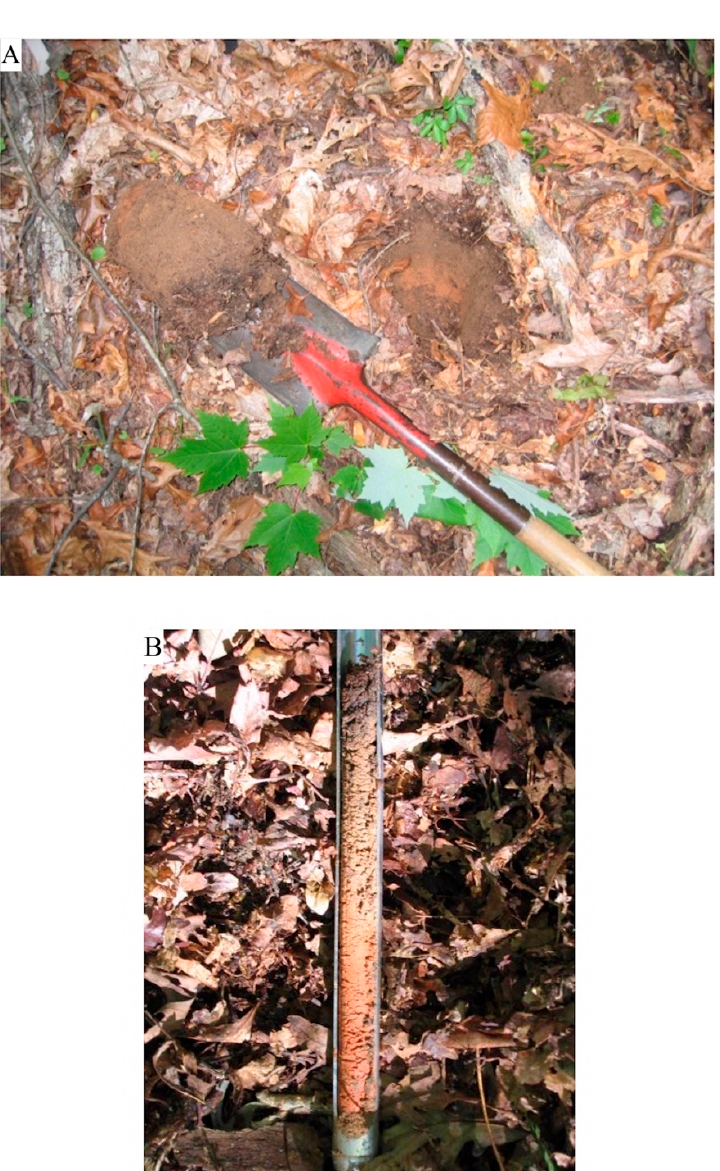
Figure 3. ( A ) Shovel samples utilized for pre-treatment soil sampling and ( B ) Oakfield soil probe samples utilized for 2018 sampling on the Green River Game Lands, Asheville, NC, USA (ultisols).